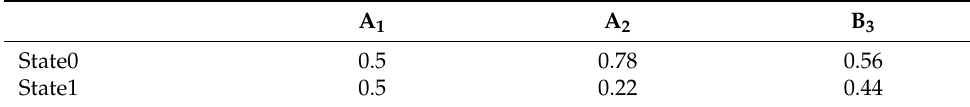
Table 4. Probability of three root nodes.